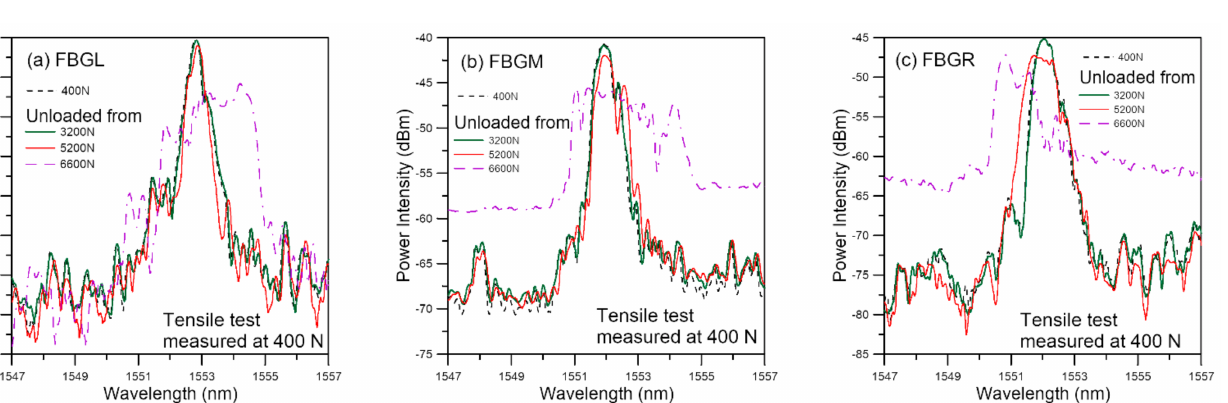
Figure 4. FBG spectra measured at 0 N after unloading from various tensile loads.